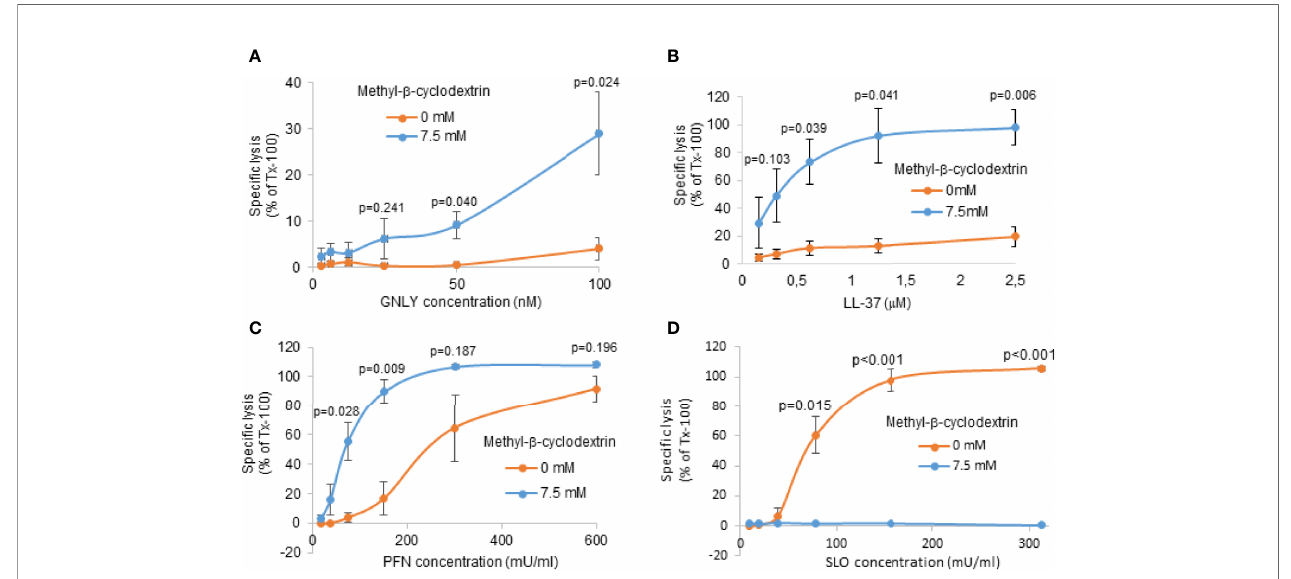
FIGURE 3 | Cholesterol depletion increases susceptibility of RBC membranes to GNLY and to PFN lysis. RBCs were pre-treated with 7.5 m M methyl- b -cyclodextrin for 2 hours at 37°C to deplete cholesterol. Depleted cells were then treated with indicated concentrations of GNLY (A) , LL-37 (B) , PFN (C) or SLO (D) for 15 minutes at 37°C before hemoglobin release was assessed by plate reader at 405 nm. Averages +/- SEM of speci fi c lysis in three independent experiments are shown. P values of differences between treatment conditions, calculated by Student`s t test, are